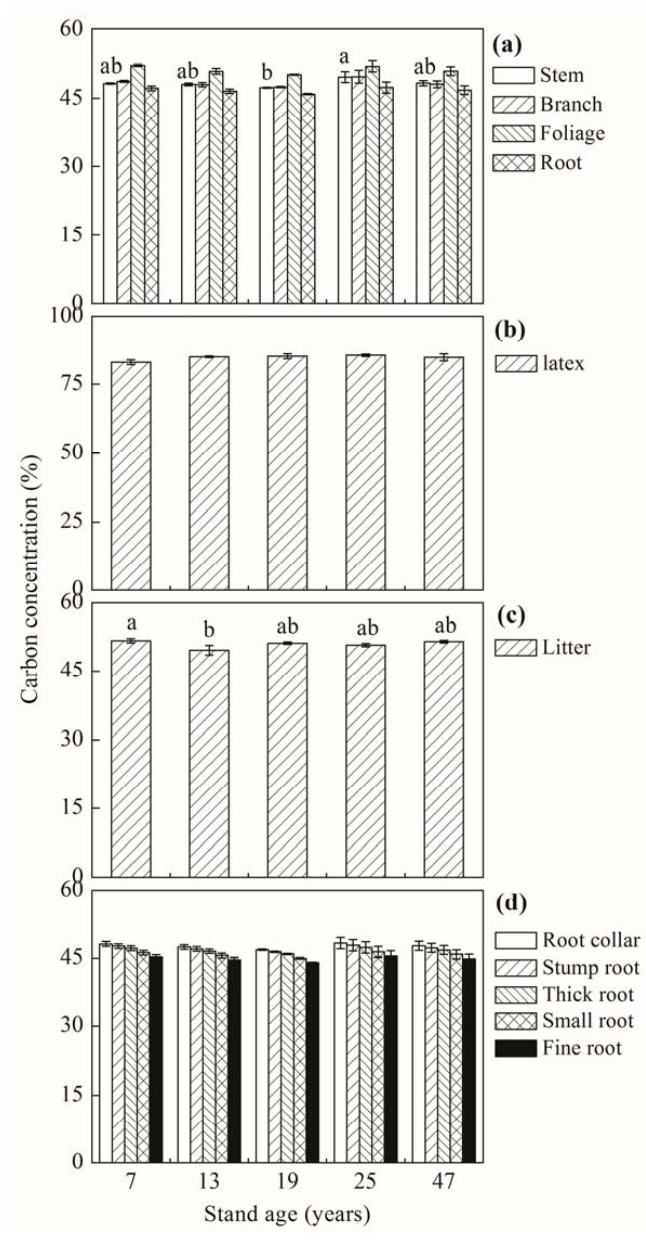
Figure 1. Carbon concentrations (as % of biomass) in different biomass compartments: tree ( a ), latex ( b ), litter ( c ) and specific root ( d ), of the 7-, 13-, 19-, 25- and 47-year-old rubber plantations at Xishuangbanna, Yunnan Province, China. Presence of different lowercase letters indicates significant differences among means of stand ages according to Tukey’s HSD test ( P < 0.05). Vertical bars show ± S.E.